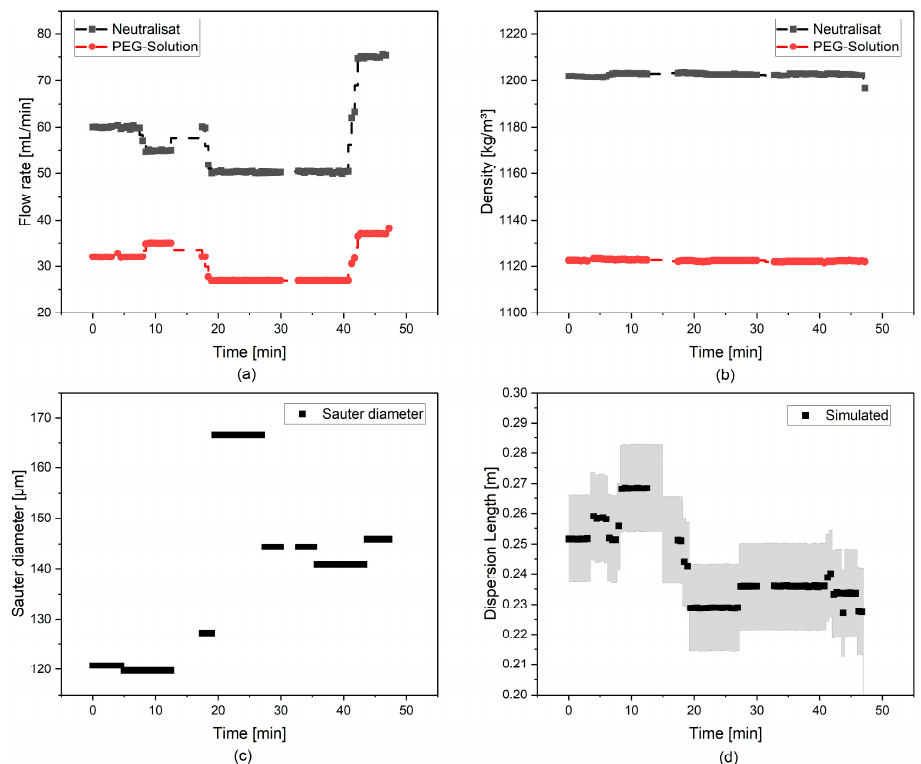
Figure 26. Plot of measured volumetric flow rate ( a ), density ( b ), Sauter diameter ( c ), and simulated and measured dispersion wedge length ( d ) from the biomass igneous ATPE test.